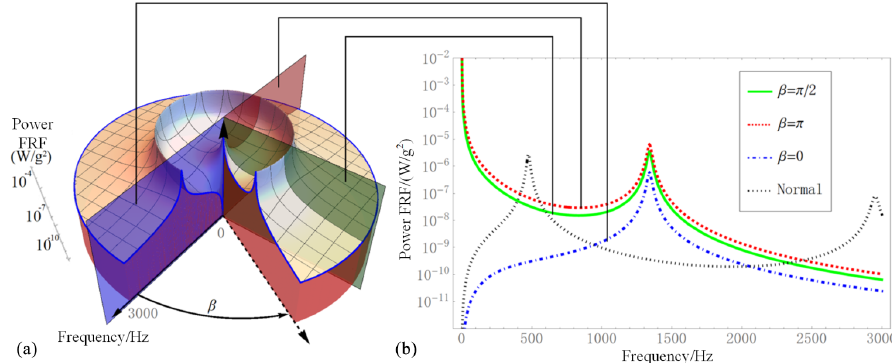
Figure 5. Variation of power FRF for frequency and phase difference ( R = 10 5 (cid:127) , a 2 = 0 . 5, and ε = 1).